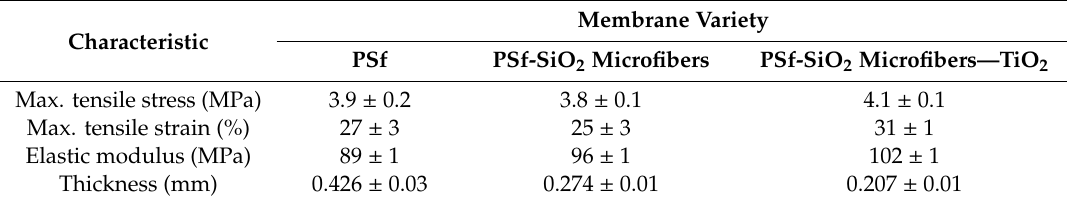
Table 4. Mechanical behavior of the composite membranes.